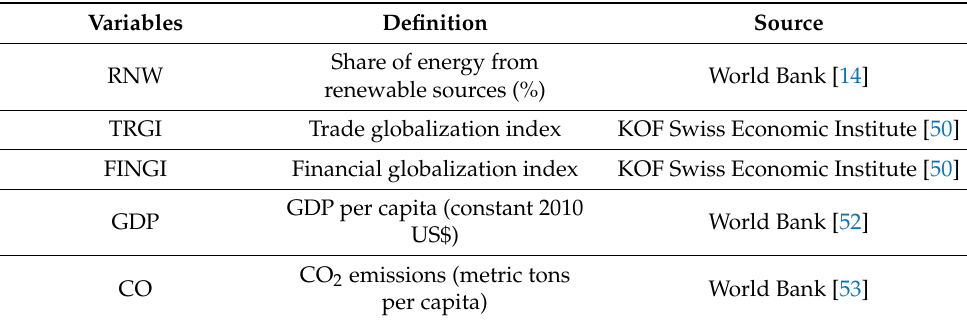
Table 2. Dataset